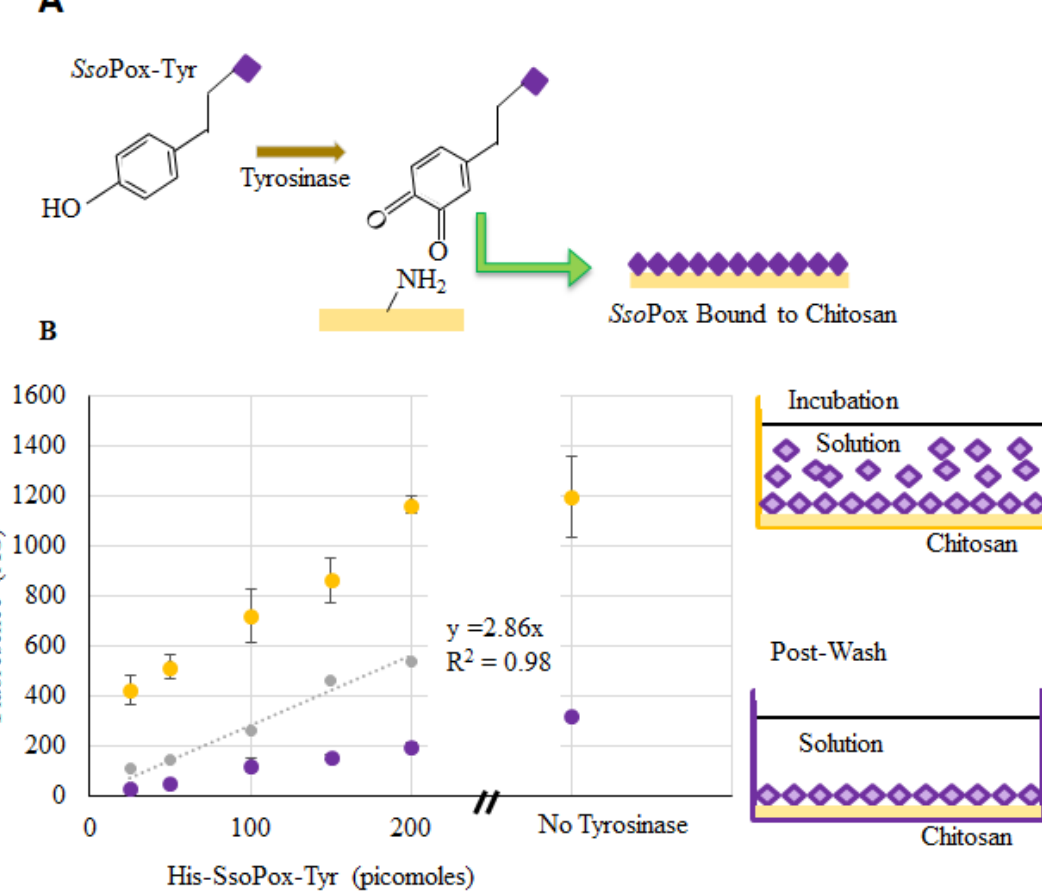
Figure 4. Sso Pox-Tyr binding to chitosan. In ( A ), the binding of Sso Pox-Tyr is illustrated using tyrosinase to form an o -quinone on the tyrosine residue which covalently links the amine groups on chitosan; ( B ) Fluorescent measurements taken at the completion of incubation (yellow) and again after washes (purple). Points indicated are the average of 3 samples, error bars are the standard deviation. The gray dataset represents a standard curve for the quantity of bound labeled enzyme.